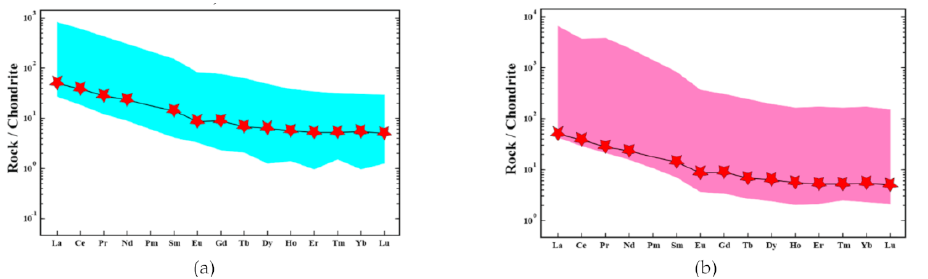
Figure 9. Comparison of the studied black sands (whole rock) REE pattern with those of ( a ) Sithonia beach sands (light blue area) and ( b ) Kavala beach sands (pink area). Symbol (red star) as in Figure